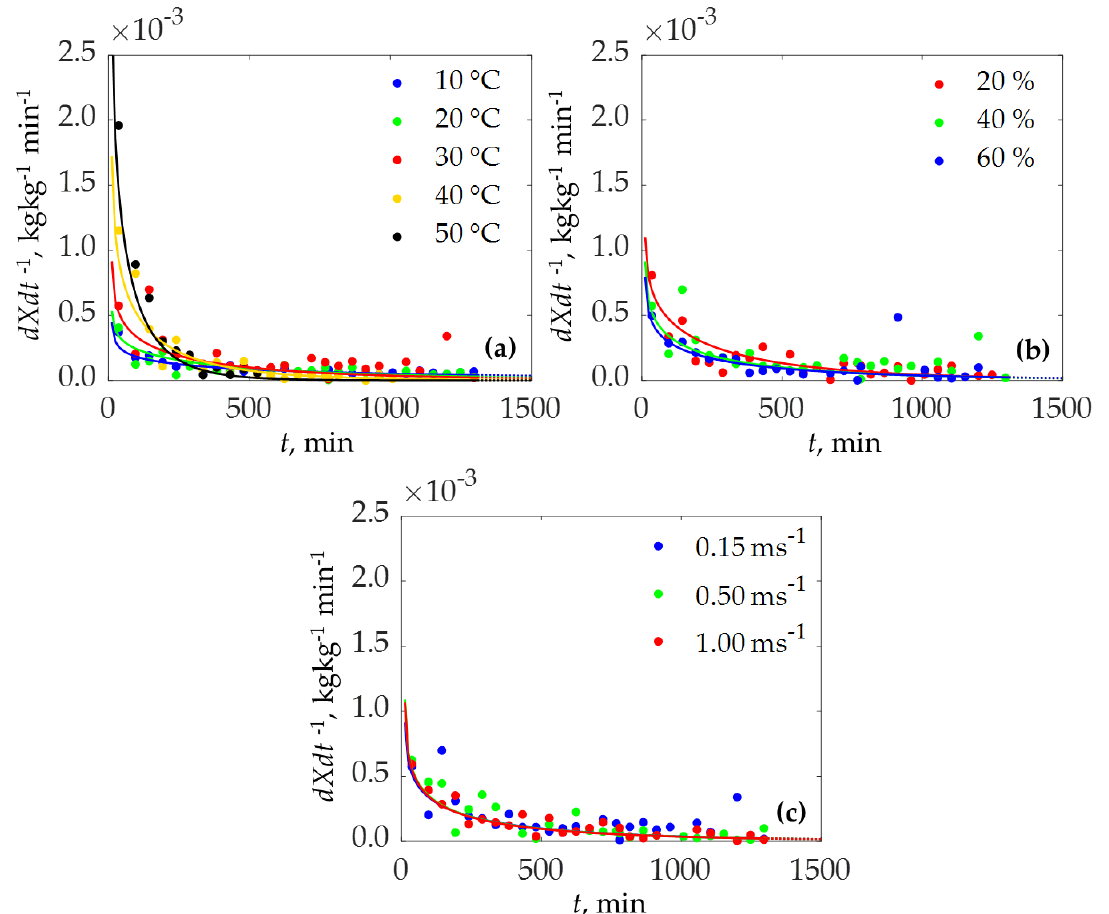
Figure 5. Drying rate dXdt − 1 vs. time t ; ( a ) temperature T ranging from 10 to 50 ◦ C at relative humidity RH = 40%, airflow velocity v = 0.15 ms − 1 ; ( b ) RH ranging from 20 to 60% at T = 30 ◦ C, v = 0.15 ms − 1 ; ( c ) v ranging from 0.15 to 1.00 ms − 1 at T = 30 ◦ C, RH = 40%. Solid lines represent Page model fitting, dashed lines show extrapolation beyond the dataset used for fitting.